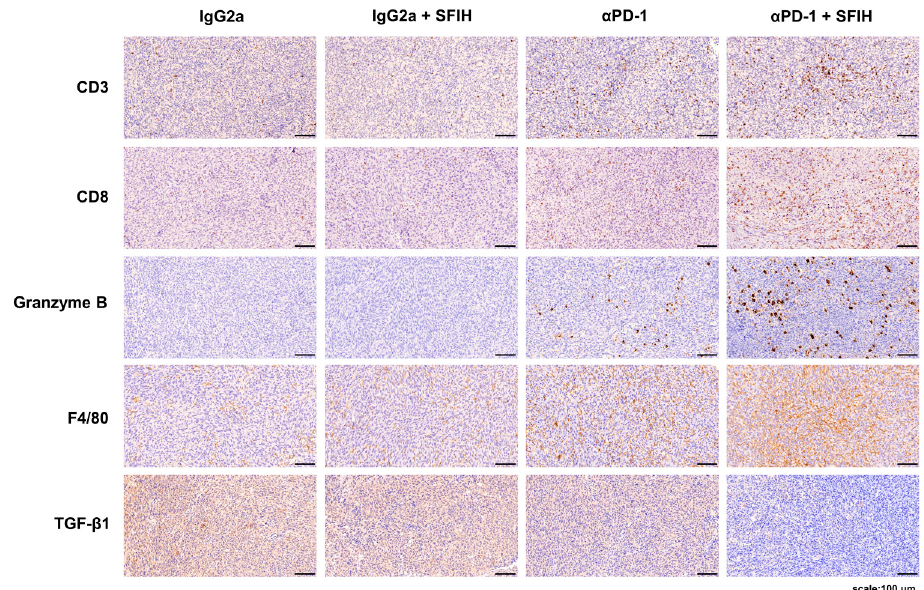
Figure 4. SFIH combined with an anti-PD-1 antibody alters the immune landscape in the tumor microenvironment. Immunohistochemistry (IHC) staining of MC38 tumors for infiltration of immune cells. CD3, CD8, granzyme B, F4/80, and TGF- β 1 levels were assessed by microscopic examination of IHC-stained sections. Representative IHC-stained images are shown (scale bars = 100 μ m).